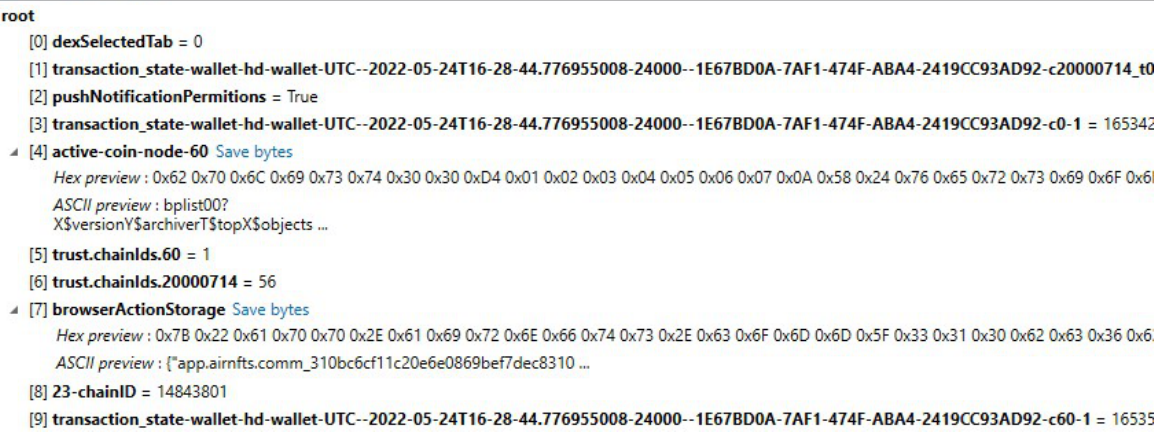
Figure 16. The com.sixdays.trust.plist file that contains information of all transactions that happened on the